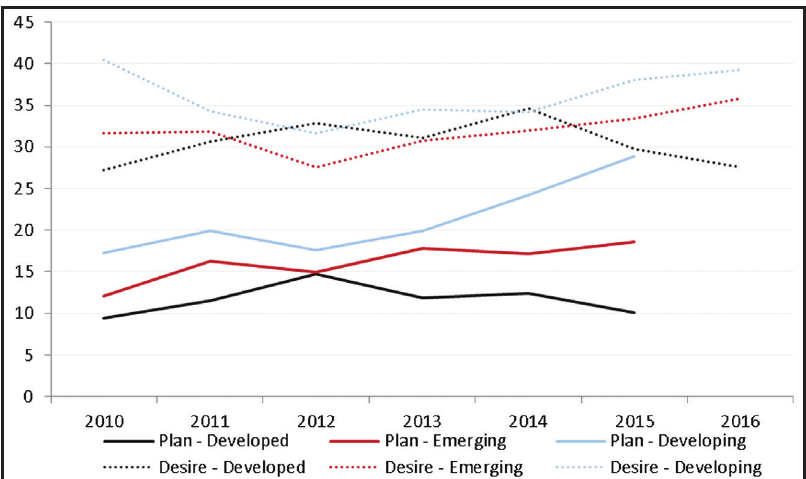
Figure 2 Percentage of youth (15–34) who desire (plan) to move abroad from 2010 to 2016.